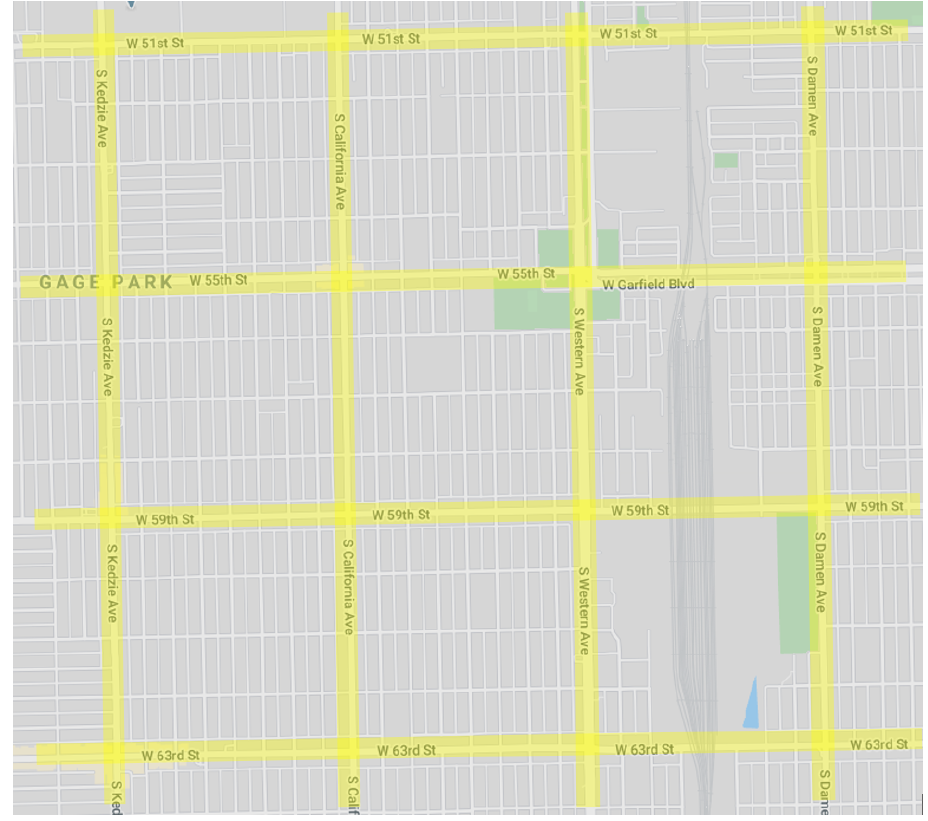
Figure 6. Simulated urban road network with signalized intersections (based on Google